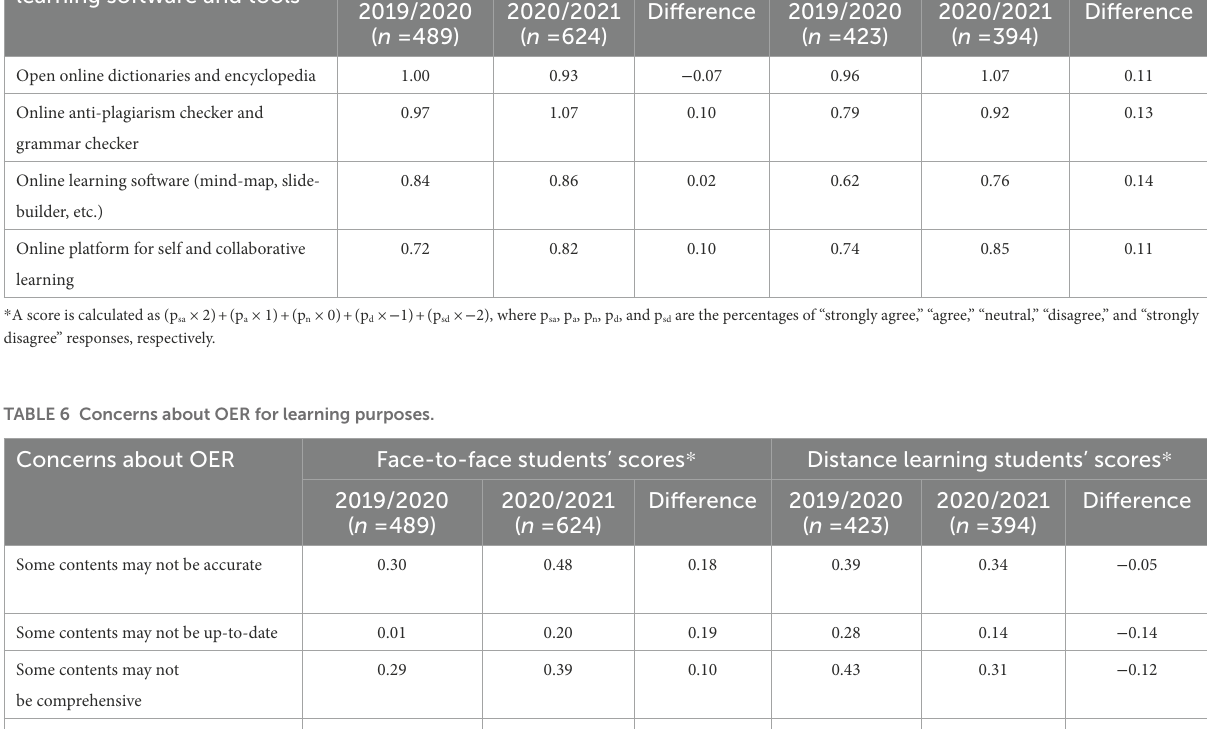
TABLE 5 Usefulness of various types of open source learning software, tools, and platforms. Types of open source learning software and